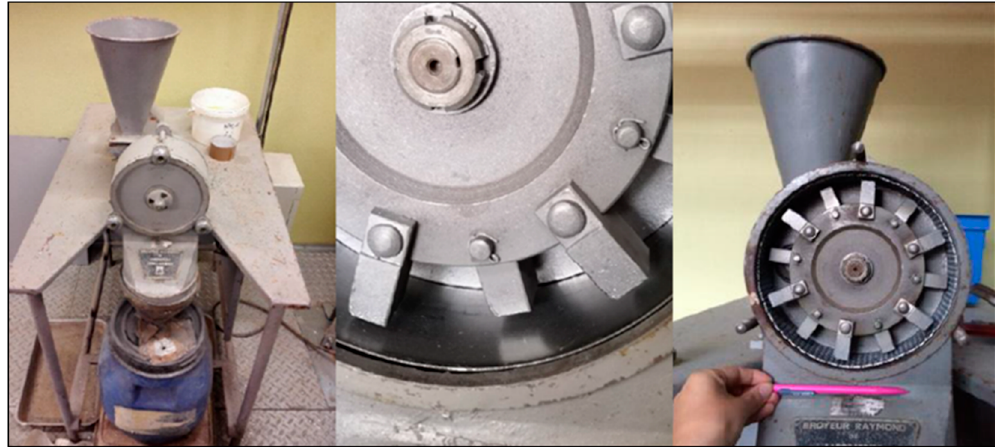
Figure 1. Raymond Hammer mill (Laboratoire Stein et Roubaix); ( Left ) the whole equipment; ( Center ) closed-circuit setting (closed lining); and ( Right ) open-circuit setting (dented lining).